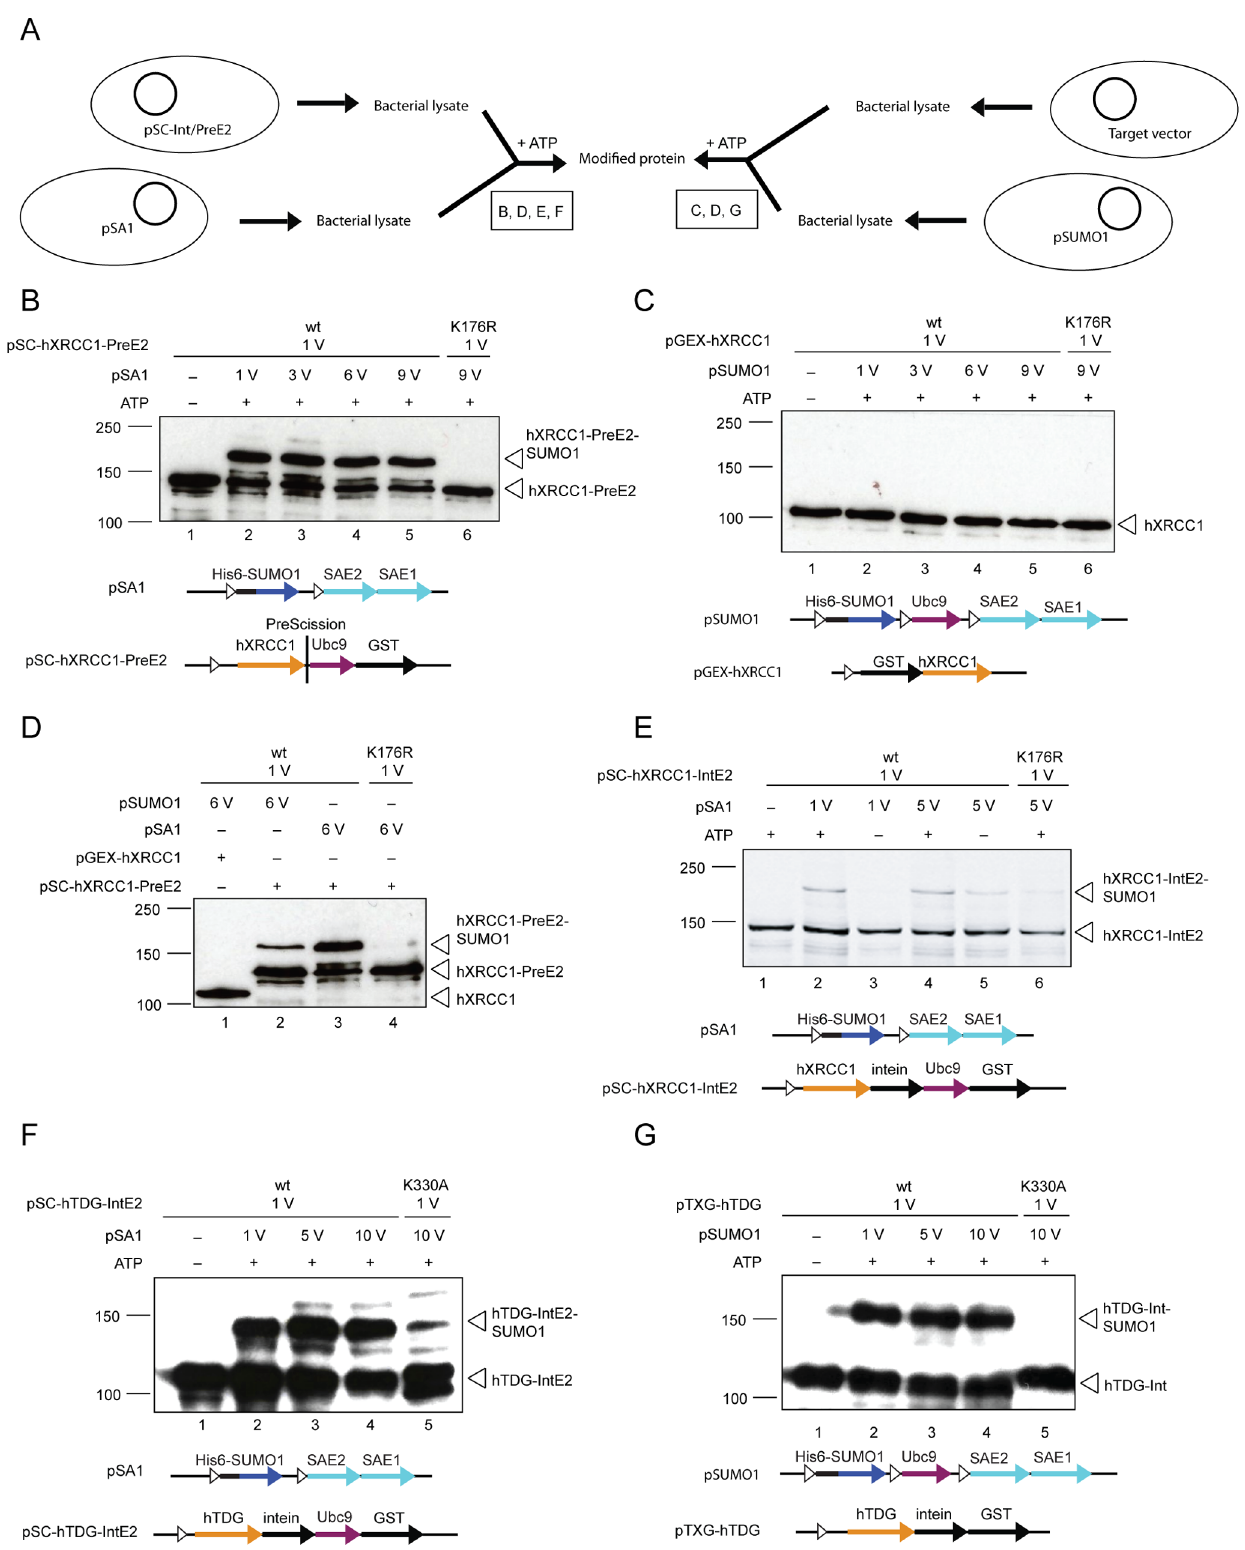
Figure 4. The SUMO-E2-fusion system allows SUMOylation of targets in crude cell extracts. ( A ) In-extract SUMOylation procedure using lysate from pSUMO1- or pSA1-expressing bacteria. Boxed letters indicate the corresponding sub-panels. In-extract SUMOylation efficiency with or without the addition ATP to a final concentration of 5 mM (30 u C for 1 h) was assessed by immunoblot analysis. Extracts from E.coli BL21(DE3) cells expressing the SA1 ( B ) or the SUMO1 ( C ) system (250 m M IPTG at 30 u C for 3 h) were mixed with extracts from cells expressing the fusion of Ubc9 to wild-type hXRCC1 (wt) or hXRCC1-K176R from the pSC-PreE2 plasmid (250 m M IPTG at 25 u C for 3 h) with the indicated volume (V) ratio. ( D ) Direct